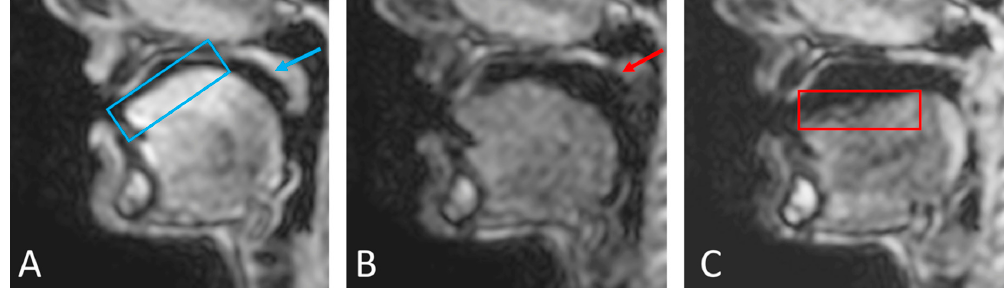
Figure 6. Varying image quality through the frames will have an effect on the initial automatic segmentation. While the velum (blue arrow) and tongue surface (blue box) can be easily automatically segmented in image ( A ), the automatic segmentation of the velum (red arrow) in image ( B ) and the tongue (red box) in image ( C ) will need manual corrections because of the signal drop-outs and artefacts caused by off-resonance.